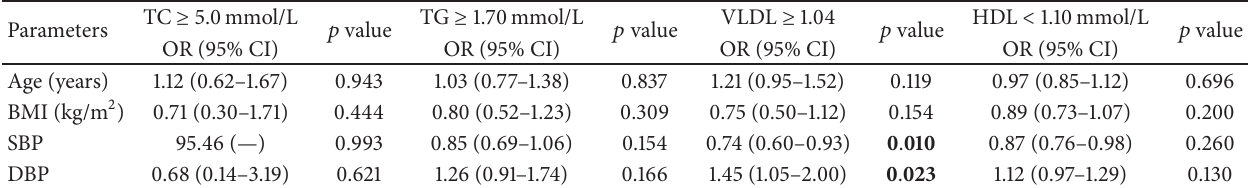
Table 3: Factors associated with high TC, TG, and VLDL and low HDL in sickle cell disease patients.